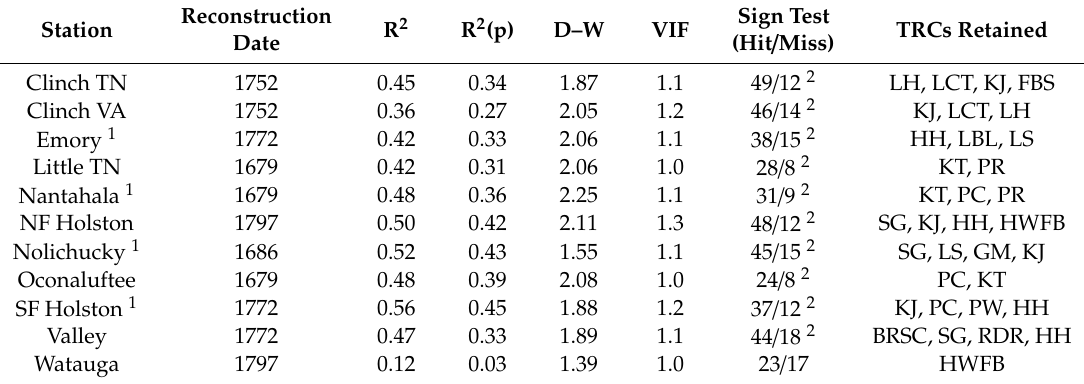
Table 2. May–June–July streamflow reconstruction statistics and Tree-Ring Chronologies (TRCs) used for each